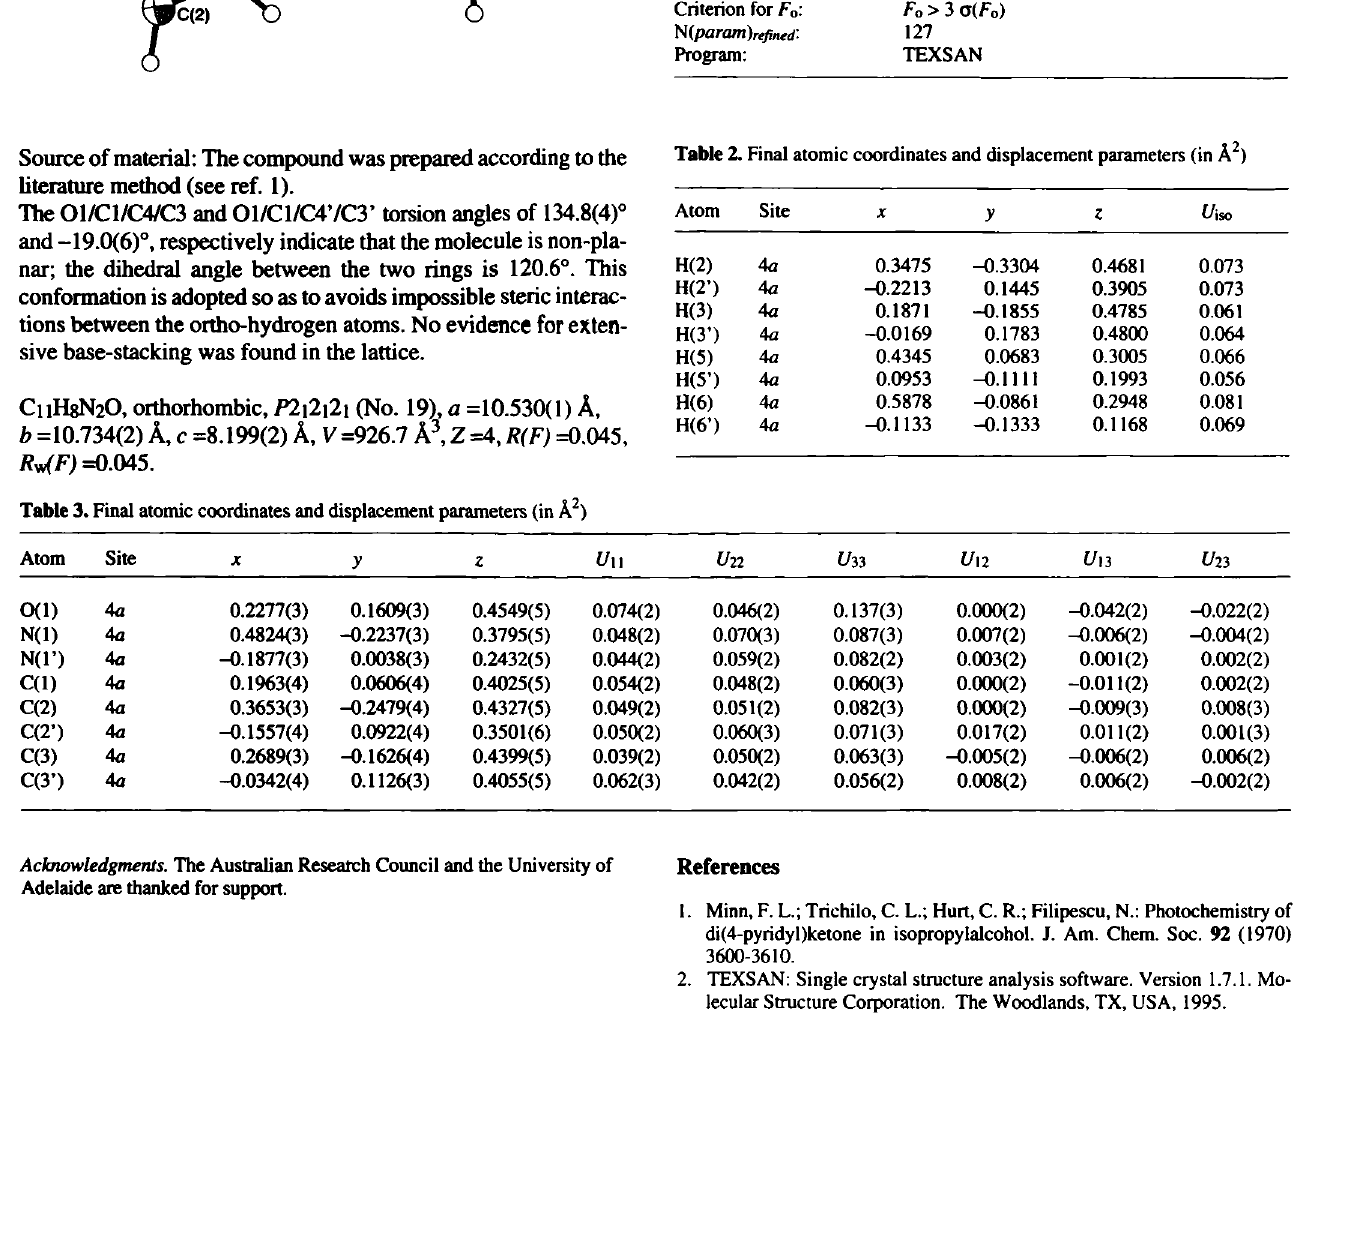
Table 1. Parameters used for the X-ray data collection